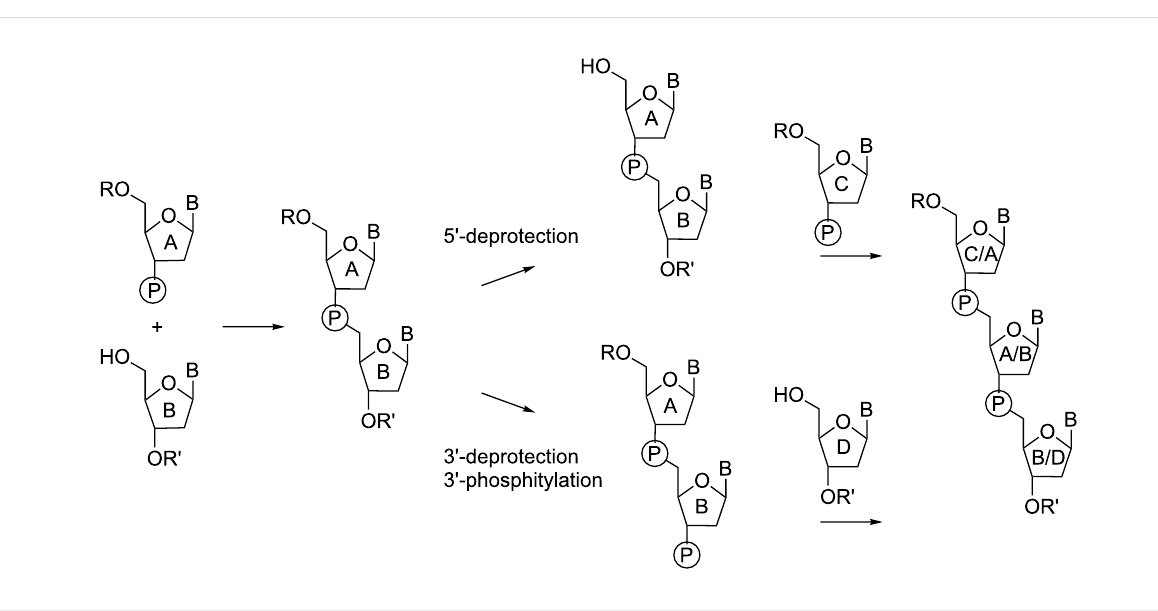
nucleotides. Both protecting groups, under the applied condi- tions, can be efficiently cleaved, at the same time leaving all other protecting groups intact. Thus, a full set of all 20 trimers was synthesized by phosphotriester chemistry starting with the condensation of N -acyl-3'- O -( o -chlorophenylphosphate)nucleo- sides to 3'- O -(2-azidomethylbenzoyl)-protected nucelosides, followed by removal of the 5'- O -DMTr group and extension of the dimer to the trimer by coupling of another N -acyl-3'- O -( o - chlorophenylphosphate)nucleoside. The final removal of the 2-azidomethylbenzoyl group occurred by reduction of the azide with triphenylphosphine in aqueous dioxane and subsequent spontaneous intramolecular cyclization leading to cleavage of the ester bond and release of the free 3'-OH group [29] (Figure